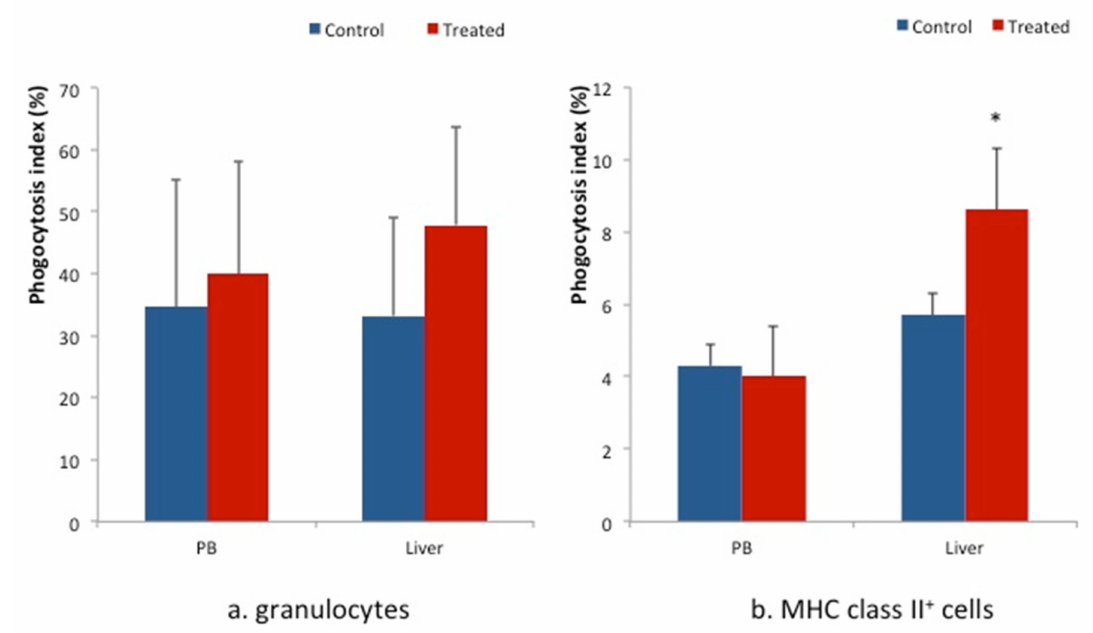
Figure 3. Phagocytosis indices of granulocytes (left side) and MHC class II + cells (right side) iso- lated from the liver and PB. The Phagocytosis index of MHC class II + cells in the livers of BT-fed piglets ( n = 10) was significantly higher than that of control piglets ( n = 7). The values represent the mean ± SD. * p < 0.05 compared to